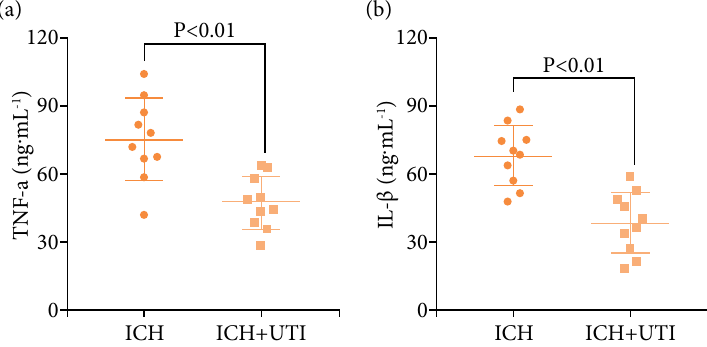
Figure 6 - UTI alleviates neuroinflammation in ICH patients. UTI significantly reduced ICH patients’ serum